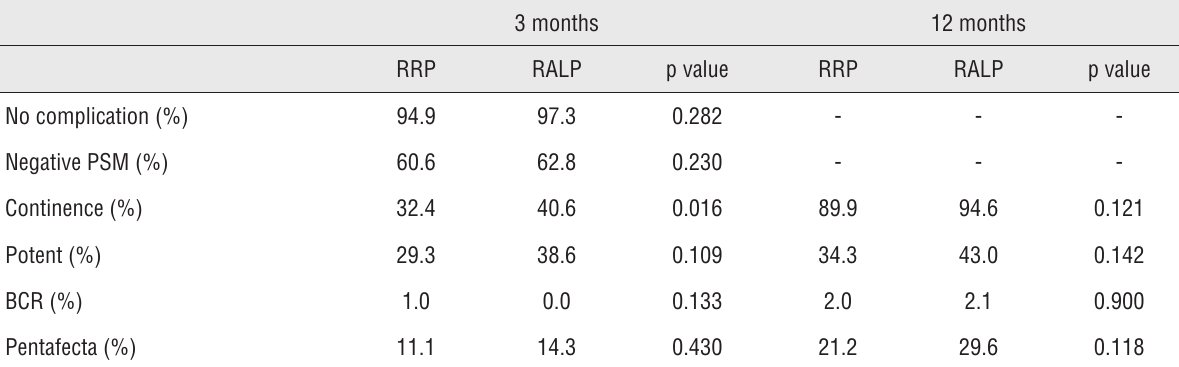
Table 3 - pentafecta success rates between RRp and RALp at 6 and 12